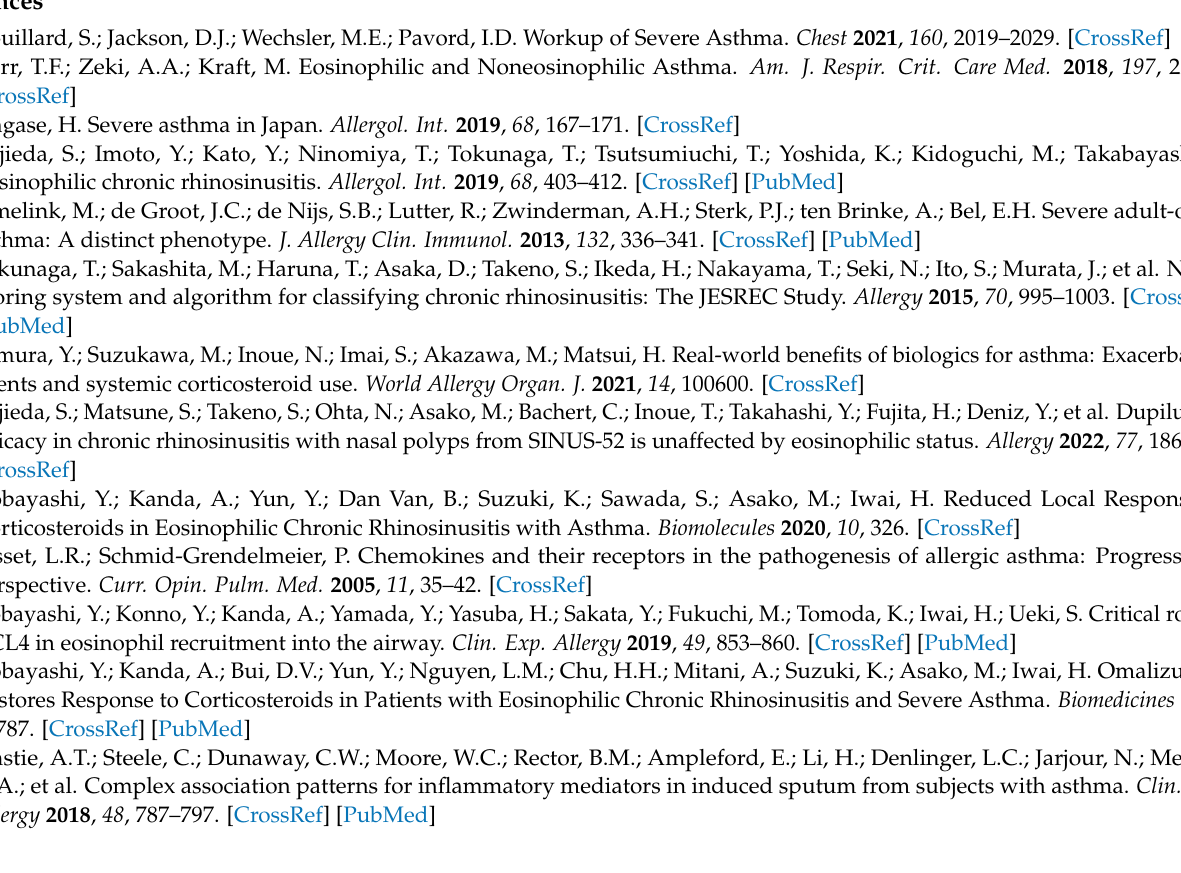
Table S2: Characteristics of patients treated with